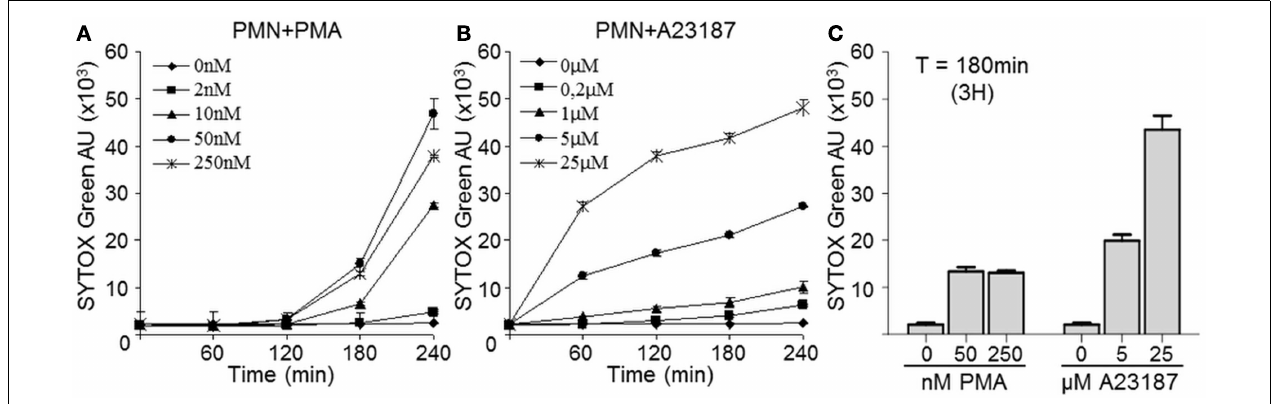
indicated times with Sytox Green. Both graphs are representative of three identical experiments and show means ± SEM of duplicate samples (C) Comparison of extracellular dsDNA levels 3h after PMA or A23187 activation; data are means ± SEM ( n = 3). AU, arbitrary